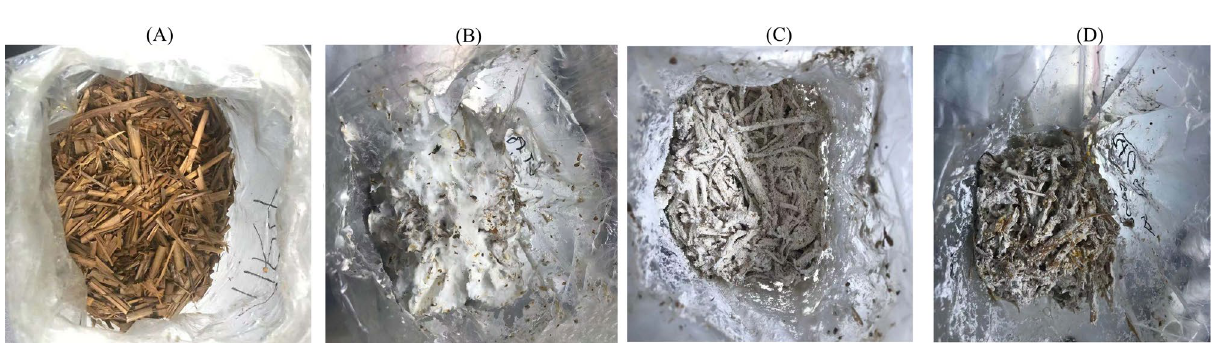
Figure 1. Mycelial confrontation test between P. chrysosporium and P. ostreatus in MEA solid plate medium: ( A ) 1 day, ( B ) 3 days, ( C ) 5 days ( D ) 7 days.